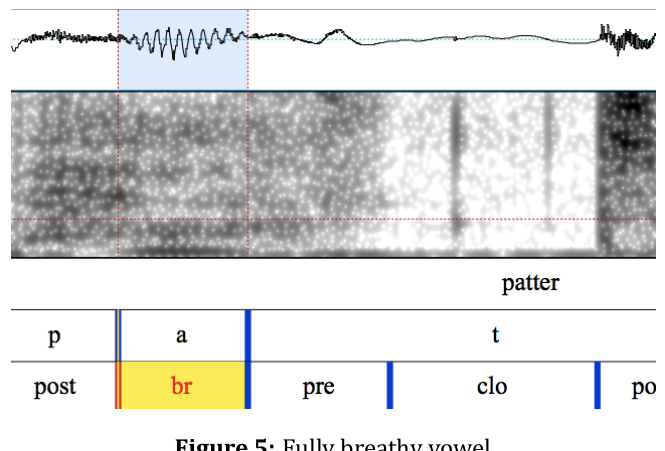
Figure 5: Fully breathy vowel.